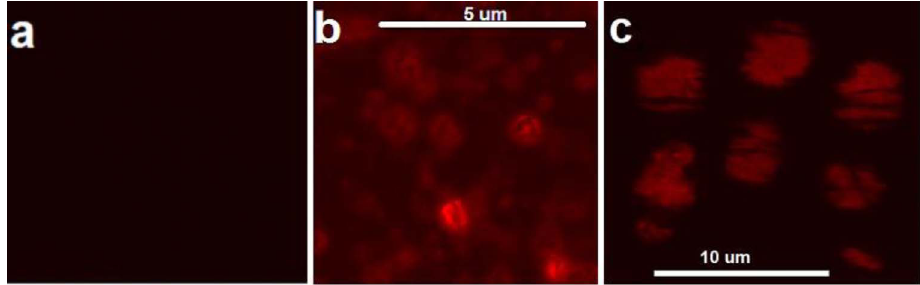
Fig. 6. Fluorescence images of (a) free HMF, (b) HMF-PDA and (c) HMF-PDA up-taken MDAMB-231